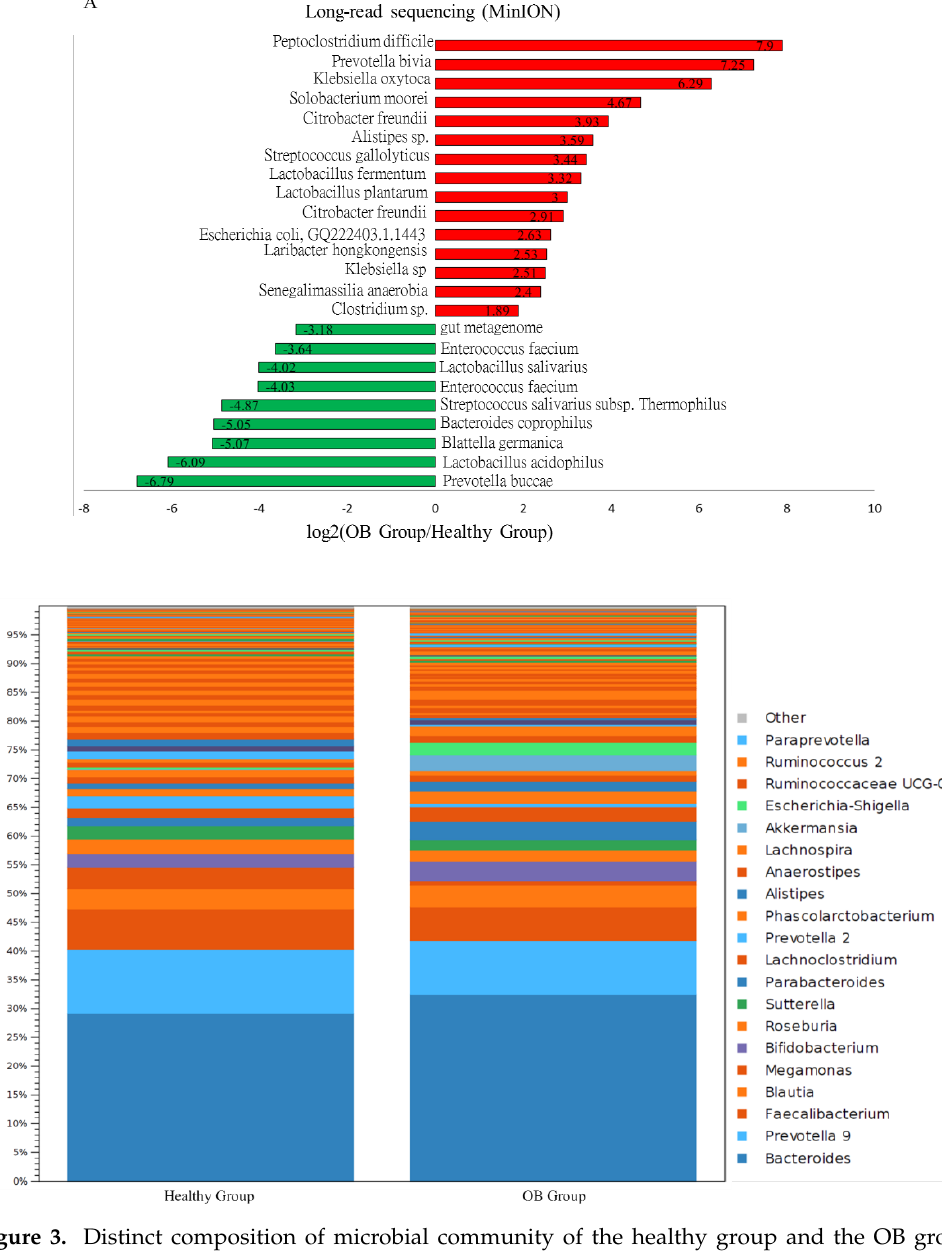
Figure 3. Distinct composition of microbial community of the healthy group and the OB group with long-read sequencing results. ( A ) Increases (red bar) or decreases (green bar) in the differential abundance of identified taxa in OB group as compared to the healthy group. ( B ) The relative levels of top 20 classified taxa in two groups with MinION results.